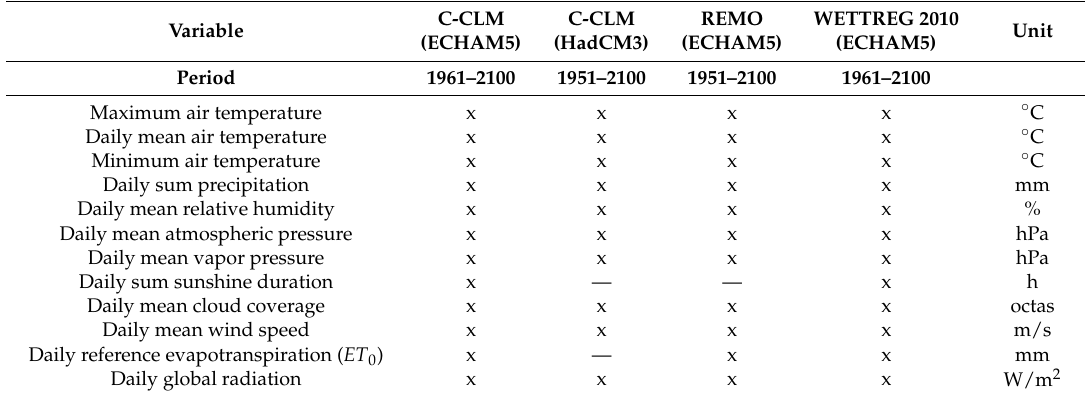
Table 1. Meteorological variables of the RCMs C-CLM, REMO and WETTREG 2010.